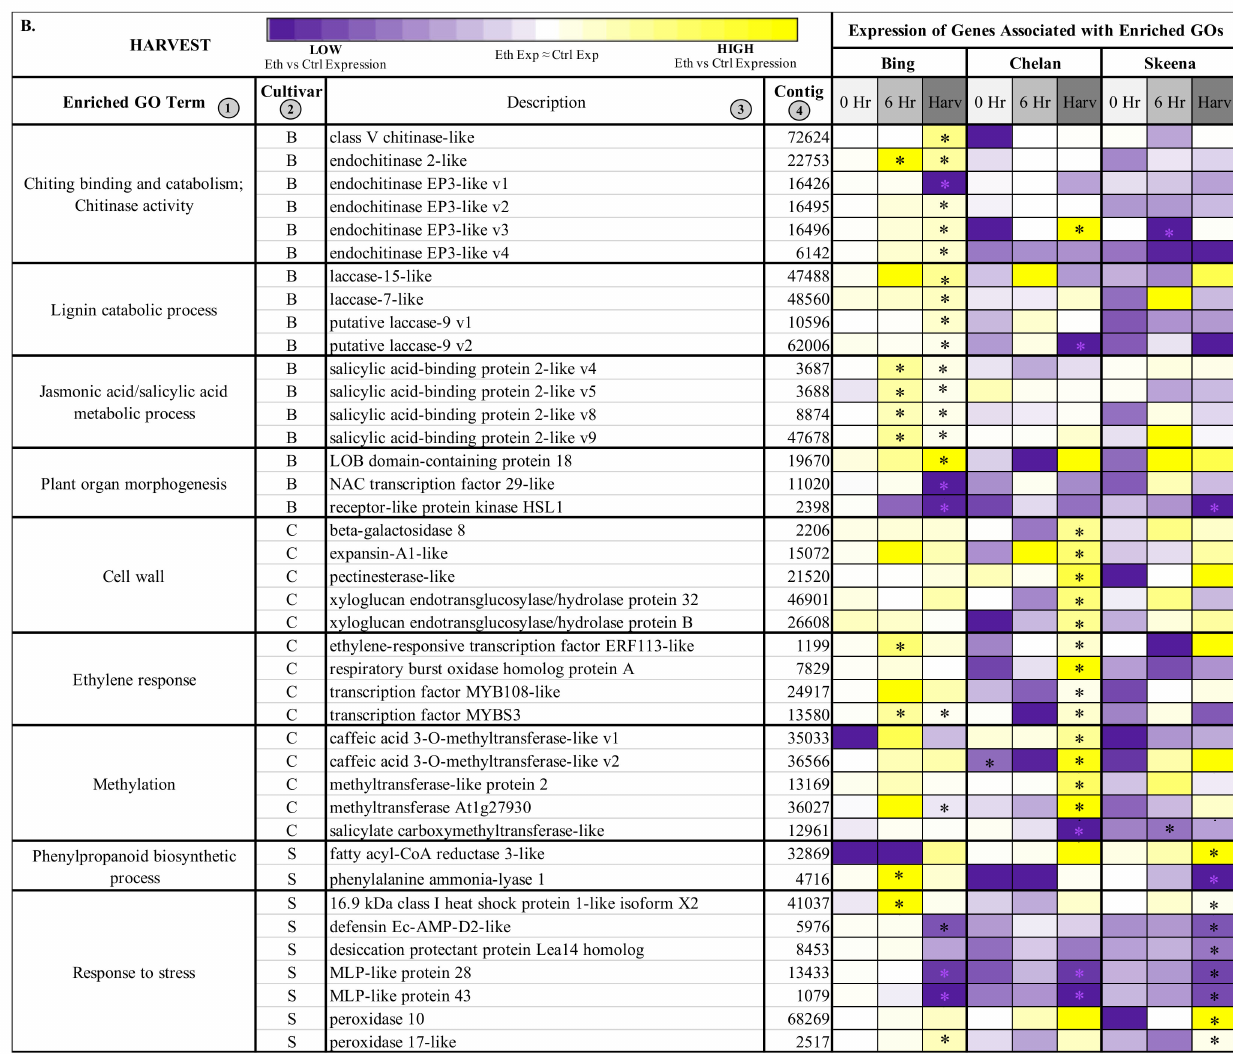
Figure 3. Heatmap displaying the expression of genes associated with significantly enriched, unique gene ontologies (GOs) for each genotype at 6 h post-ethephon treatment ( A ) and at harvest ( B ). Columns 1 and 2 display enriched GO terms and the genotype for which they were enriched, respectively. Columns 3 and 4 display the names of the differentially expressed genes associated with each enriched GO and their corresponding contig numbers, respectively. Heatmap represents fold change expression of ethephon-treated abscission zones (AZs) versus the control AZs for each cultivar. Asterisk indicates significant differential expression (Kal’s Z-test FDR-corrected p -value < 0.05, NOISeq DE probability > 0.8, |Log2FC| >